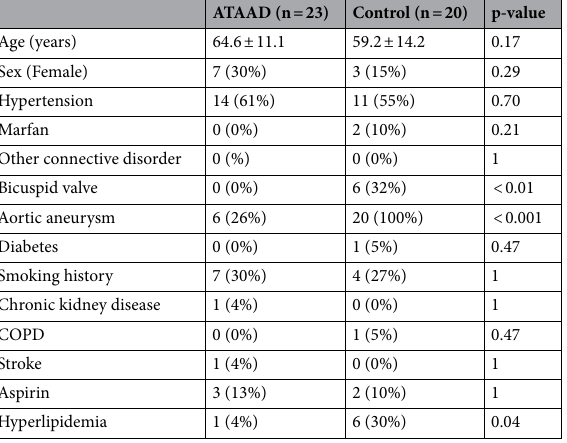
Table 1. Preoperative characteristics. Values are expressed as numbers (%) or mean ± SD. ATAAD acute aortic dissection, COPD chronic obstructive pulmonary disease.